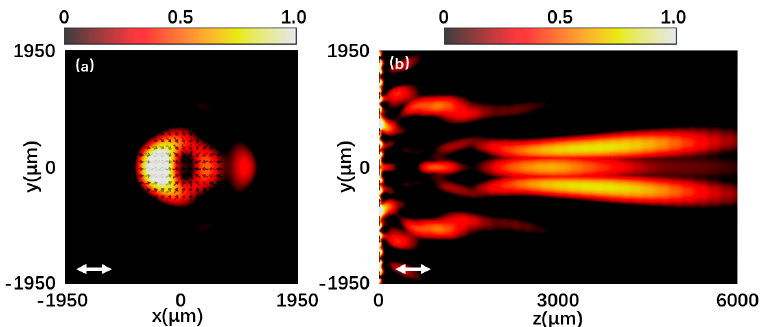
Figure 5. ( a , b ) Normalized intensity distribution at 0.7 THz under the x-polarized light incidence.